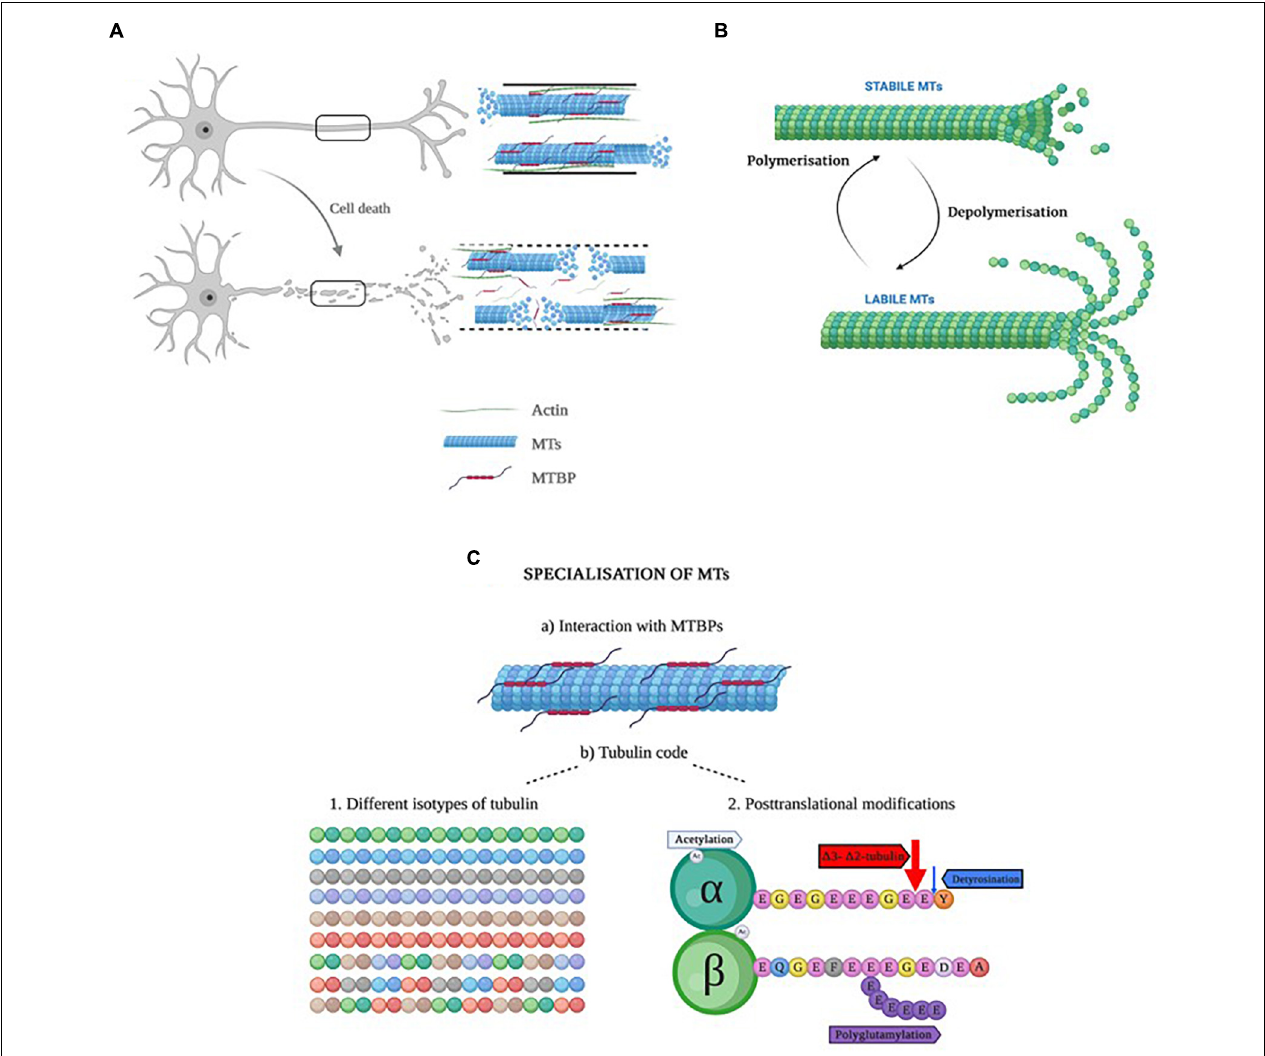
FIGURE 2 | (A) Representation of a healthy neuron with a healthy cytoskeleton (top), and a neuron in apoptosis with increased ratio of labile to stabile MTs. (B) Representation of the dynamic instability process in microtubules. When MTs are highly dynamic, they are called labile, whereas when the dynamics are slow, they are named stable MTs (Li and Black, 1996). The important aspect of dynamic instability is the presence of stochastic changes between a growth and a shrinkage phase and vice versa. These two phases can occur in parallel in the cells. The dynamic instability is energy-dependent and driven by GTP hydrolysis. (C) Schematic representation of the specialization of MTs. Created with